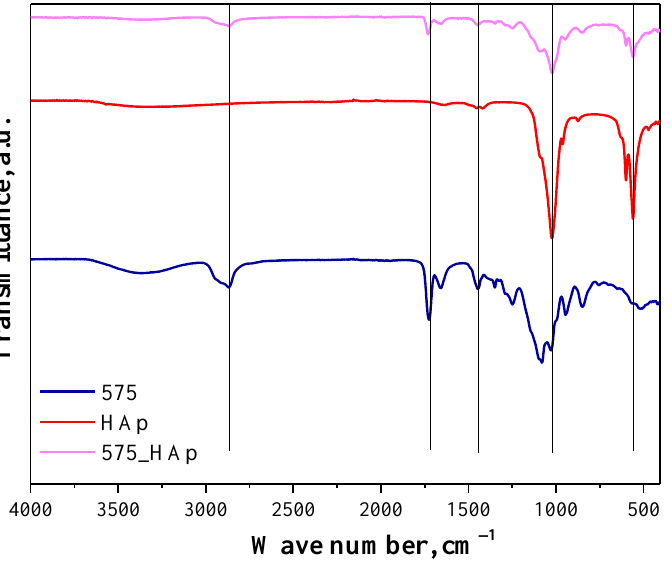
Figure 6. FT-IR spectrum of HAp (red), polymer matrix obtained using PEGDA 575 (575, blue) and the composite obtained using the same crosslinker (575_HAp; pink).